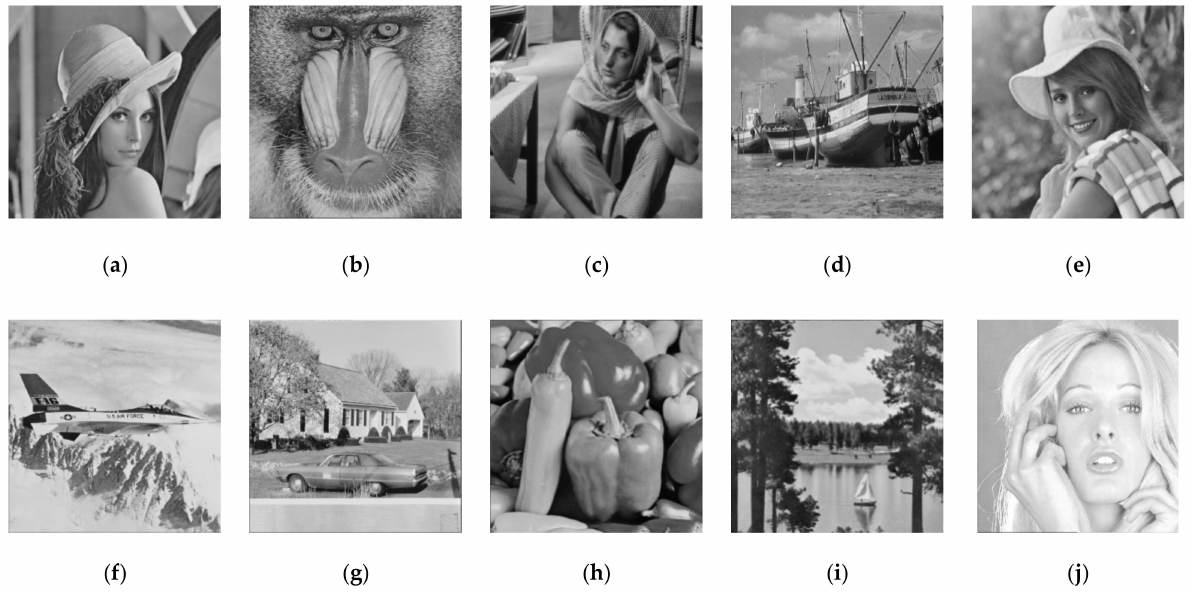
Figure 8. Ten test images which are ( a ) Lena ( b ) Baboon ( c ) Barbara ( d ) Boat ( e ) Elaine ( f ) F16 ( g ) House ( h ) Pepper ( i ) Sailboat ( j ) Tiffany